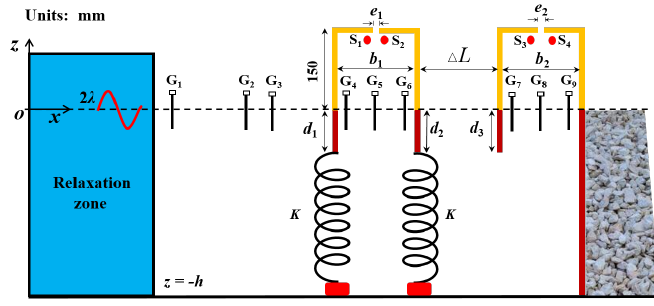
Figure 10. Numerical setup of the present dual-OWC-device system with a gap.